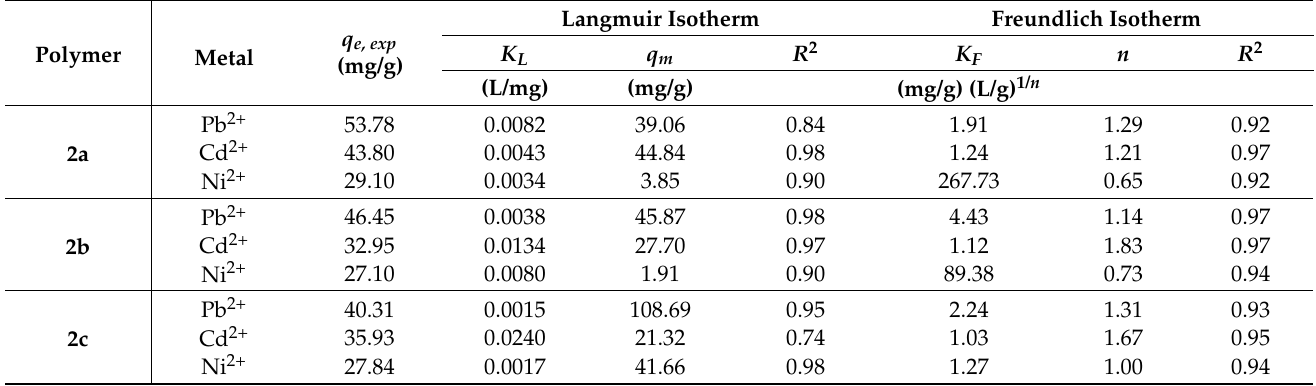
Table 3. Parameters of the Langmuir and Freundlich models for the adsorption of individual Pb 2+ , Cd 2+ and Ni 2+ ions by the thiol-functionalized